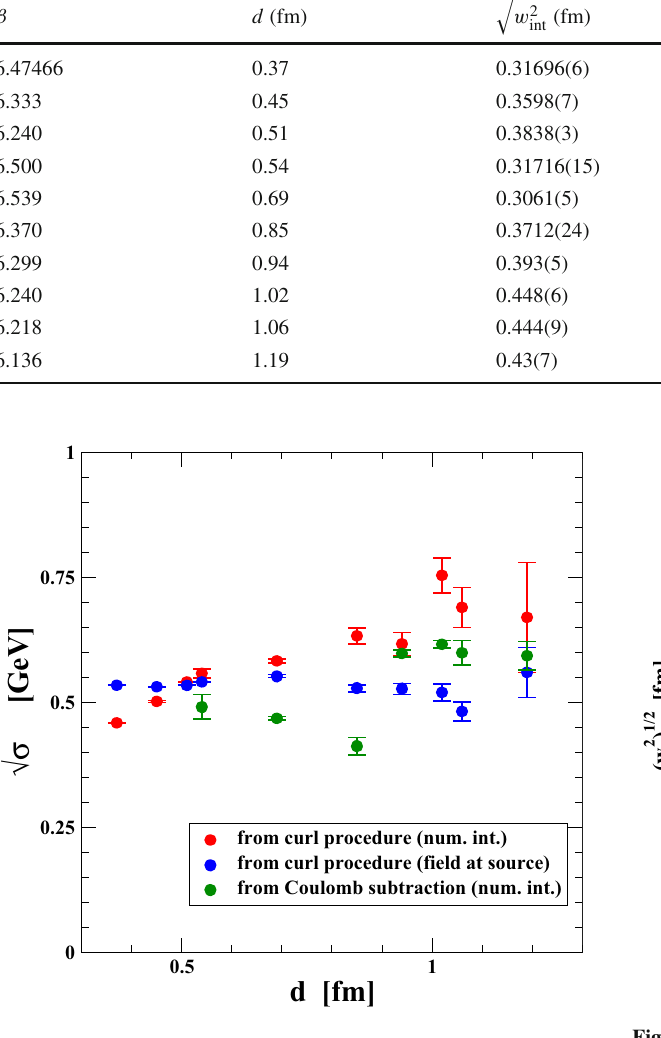
Fig. 9 The square root of the string tension obtained using several differentprocedures:(i)bynumericalintegrationofEq.(8)withthenon- perturbativefieldobtainedfromthecurlprocedure(Sect.4);(ii)fromthe non-perturbative field obtained from the curl procedure evaluated and evaluated at sources; (iii) by numerical integration of Eq. (8) with the non-perturbative field obtained from the Coulomb subtraction (Eq. (4))